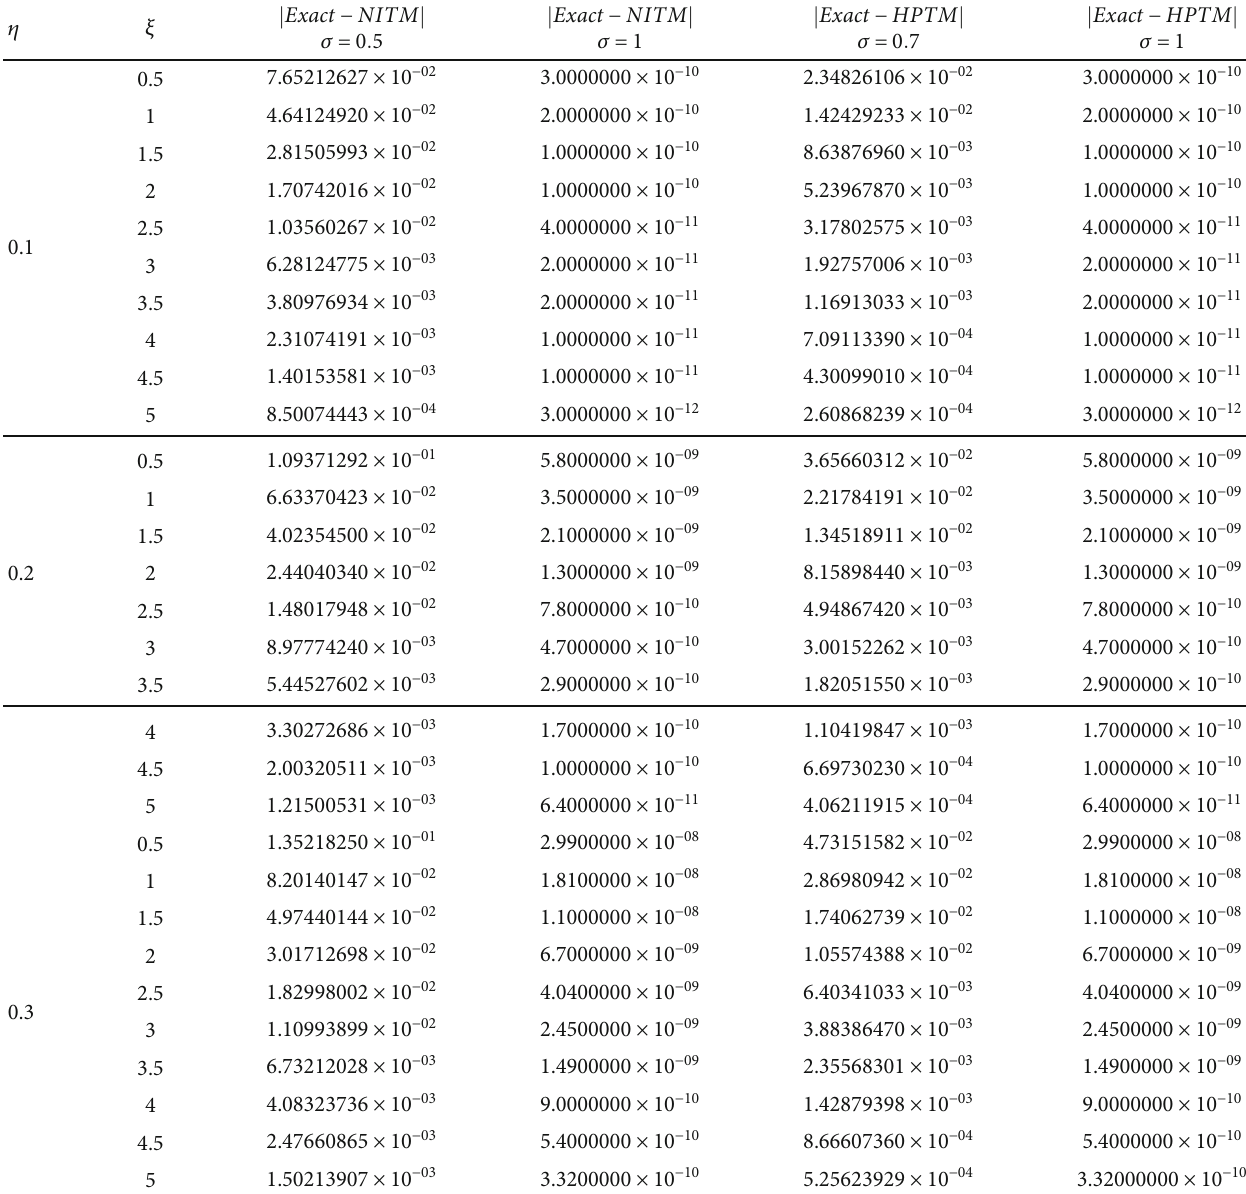
Table 1: Analysis of the approximate solution by NITM and HPTM for problem